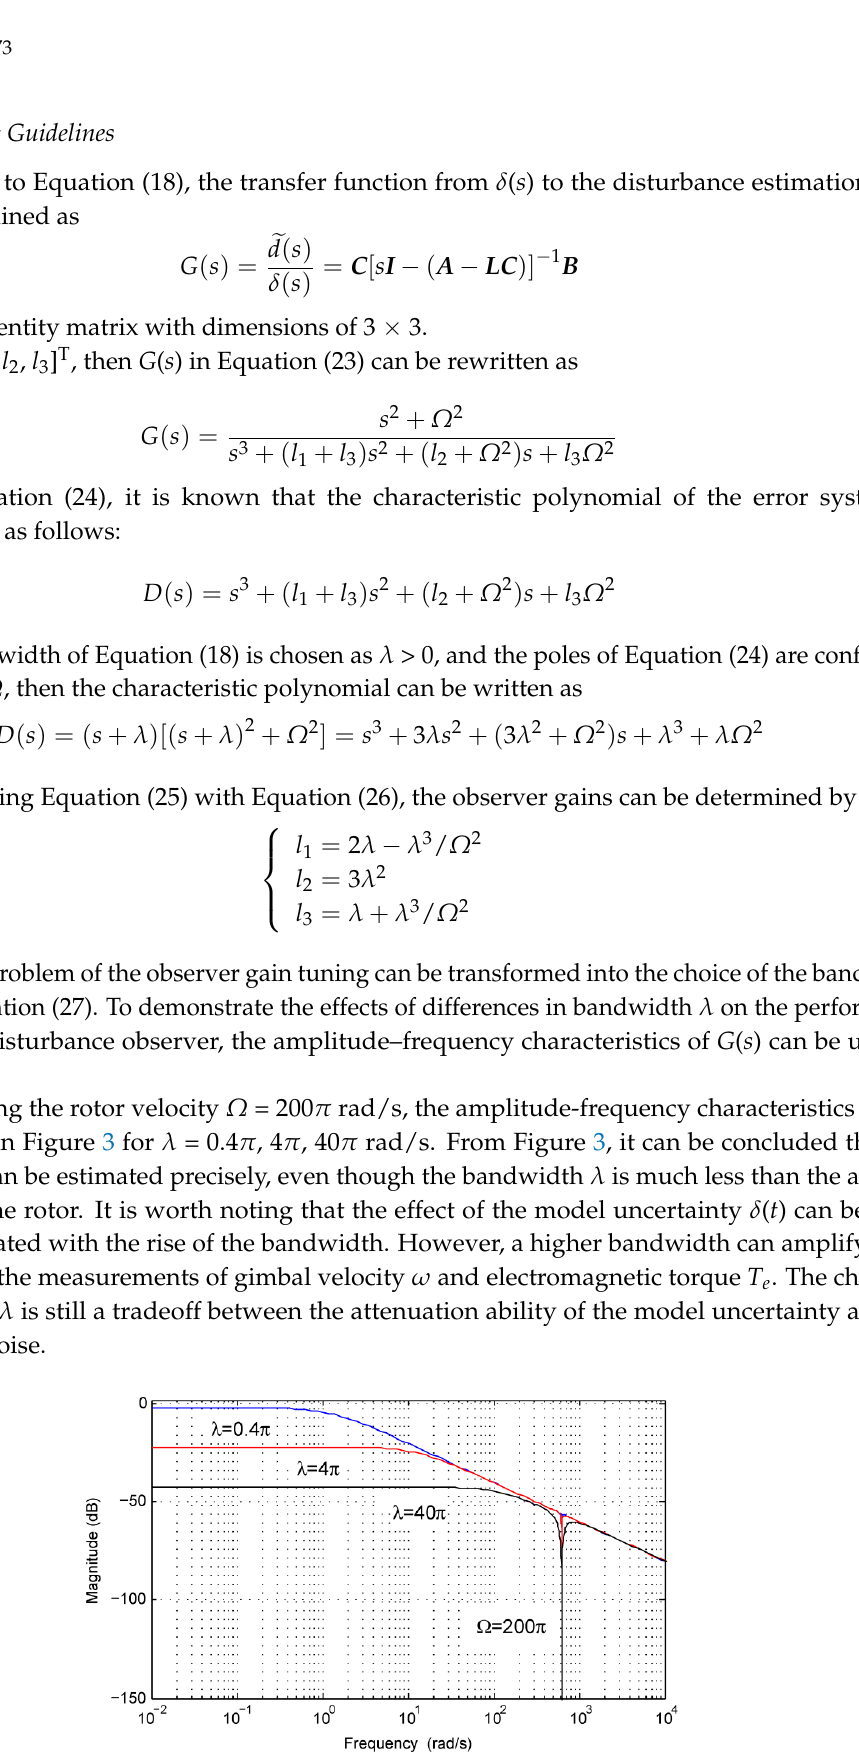
Figure 3. Amplitude–frequency characteristics of G ( s ).